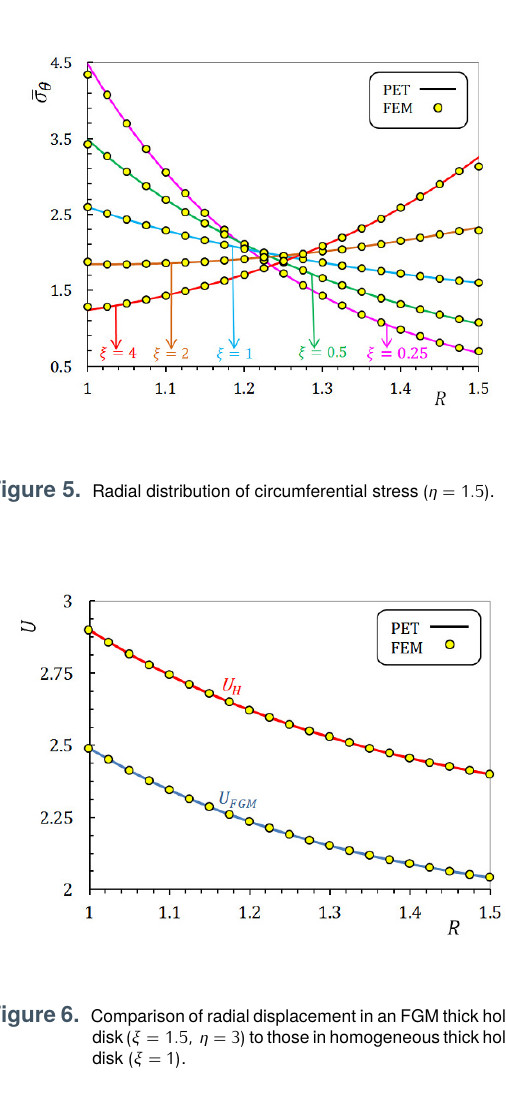
= 1 . 5 ). Figure 6. Comparison of radial displacement in an FGM thick hollow disk ( ξ = 1 . 5 , η = 3) tothoseinhomogeneousthickhollow disk ( ξ = 1) .